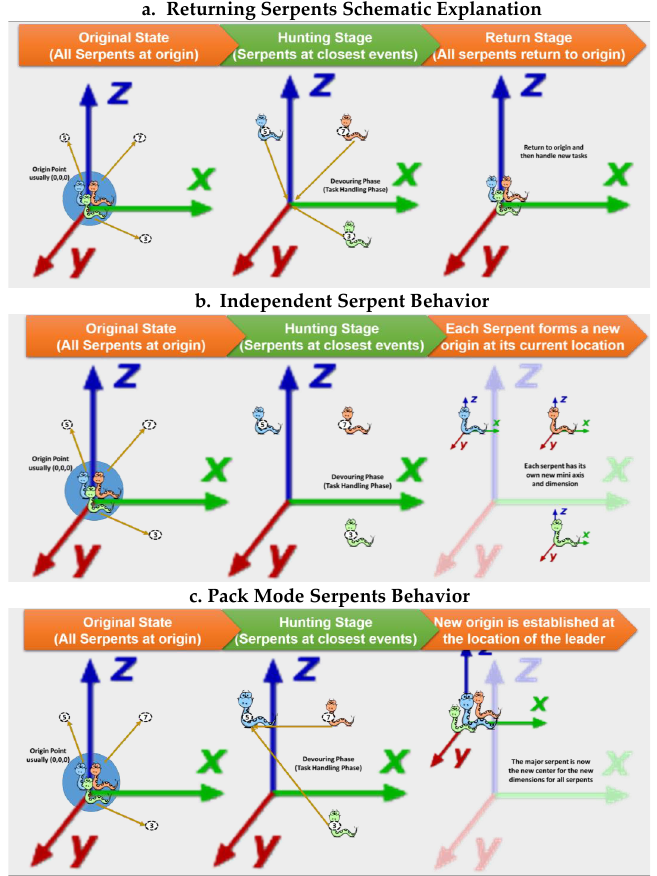
Figure 4. Serpent behavior modes.